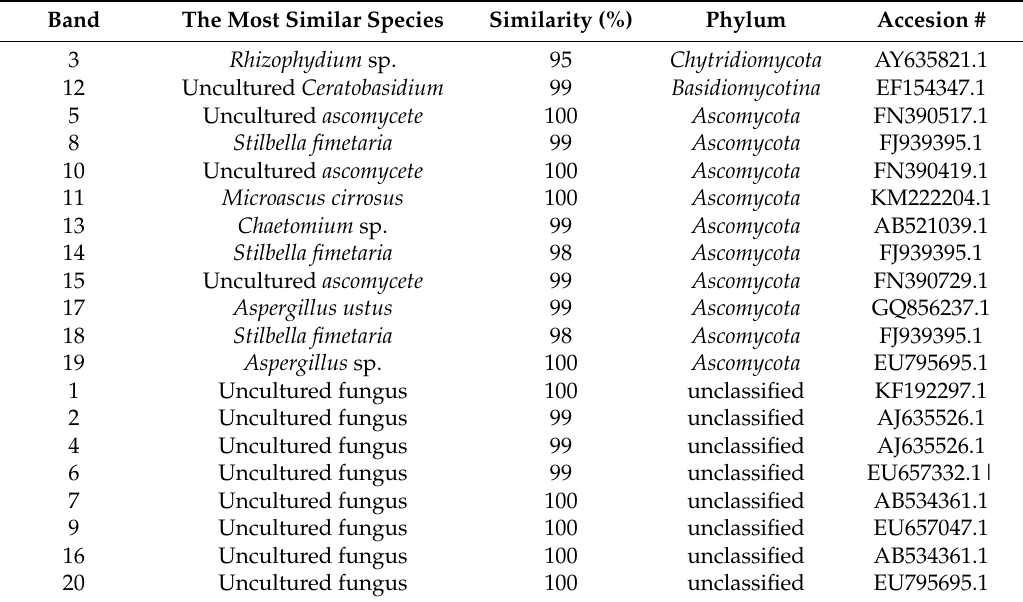
Figure 4. DGGE banding patterns of ITS fragments. Numbers indicate the excised and sequenced ITS bands. Lane labels denote samples from the treatments in this study (S0D, S10D, S32D: soils untreated and sampled in 0, 10 and 32 day. SB0D, SB10D, SB32D: B subtilis B068150-NR was introduced in to soils and sampled in 0, 10 and 32 day). Table 4. Sequence similarity of bands of the main fungi in different cucumber rhizosphere soil samples in